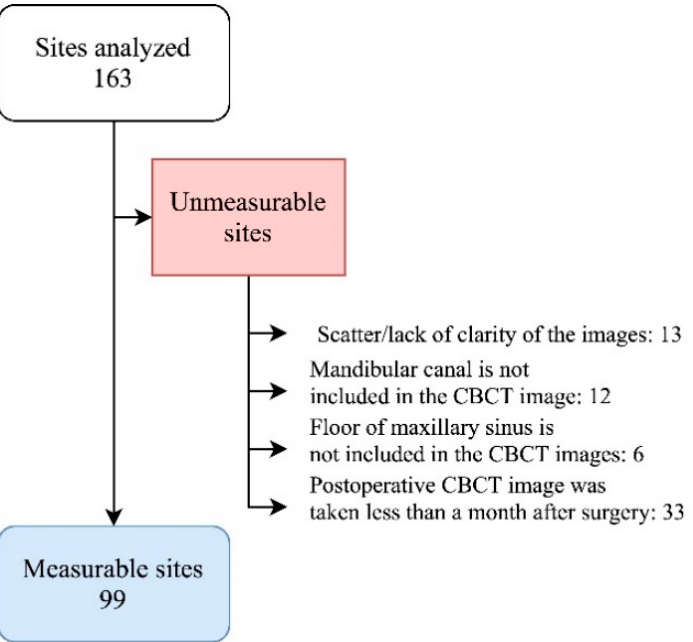
Figure 1. Flow chart of cone-beam computed tomography (CBCT) selection.